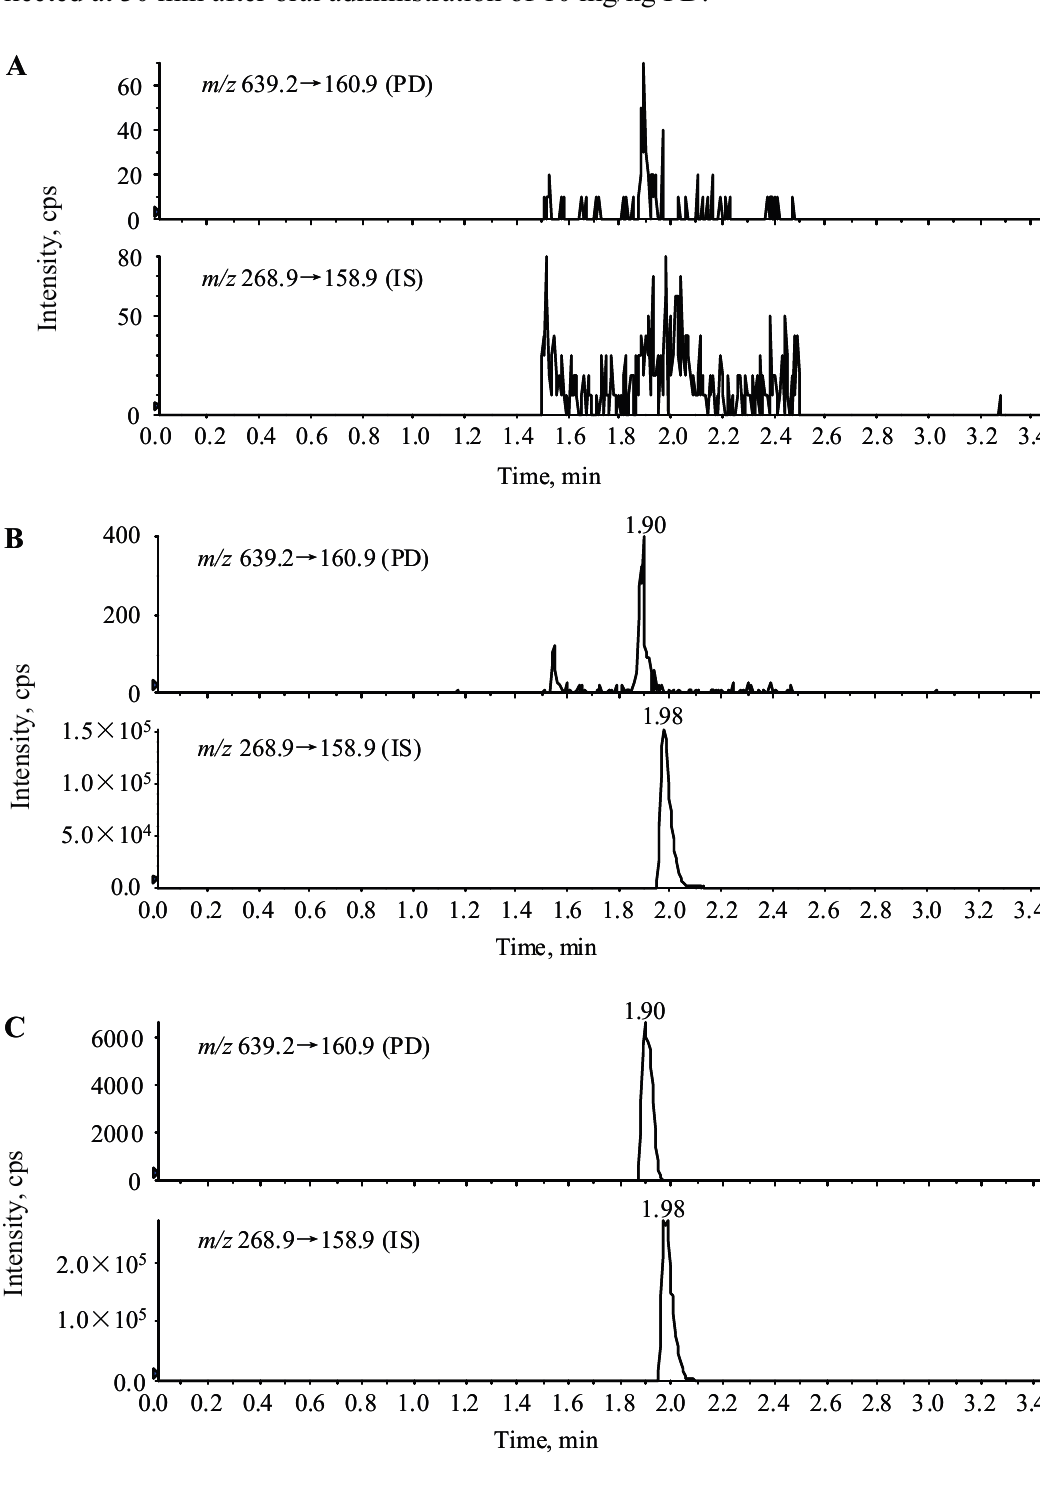
Figure 3. Typical chromatograms of ( A ) blank rat plasma; ( B ) blank rat plasma spiked with PD (0.1 ng/mL, LLOQ) and IS; ( C ) an unknown rat plasma sample collected at 15 min after intravenous administration of 2.0 mg/kg PD; and ( D ) an unknown rat plasma sample collected at 30 min after oral administration of 10 mg/kg